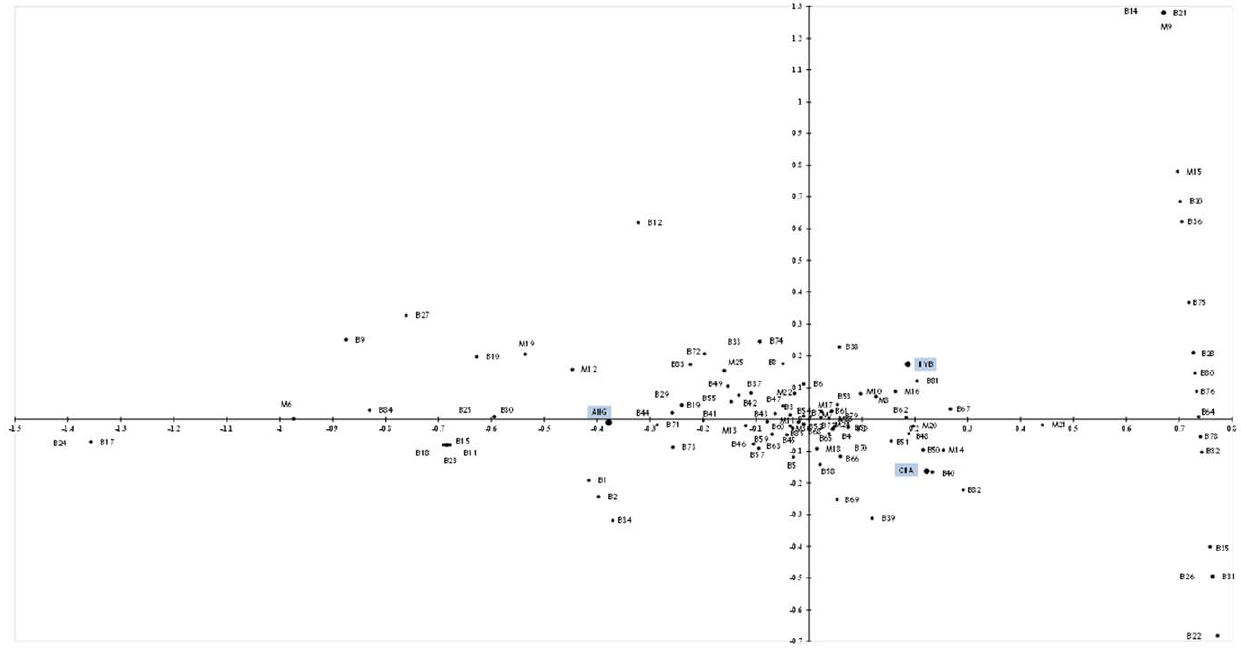
Figure 2. Correspondence Analysis (CA) plot displaying the interactions among frequencies of bacterial and methanogen phylotypes and sire breed. Structural relationships among frequencies were displayed in a data cloud, where Dimension 1 indicated the frequency of either methanogen or bacterial phylotypes (column coordinates) while Dimension 2 depicts the associations of these observed frequencies and breed (row coordinates).